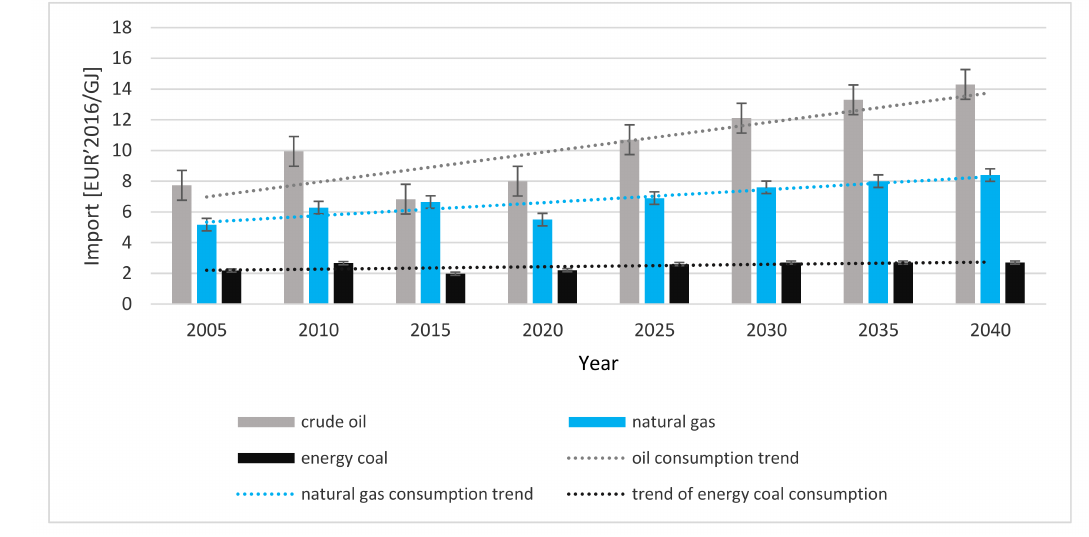
Figure 3. Price developments of imports into the European Union; own study based on [47].